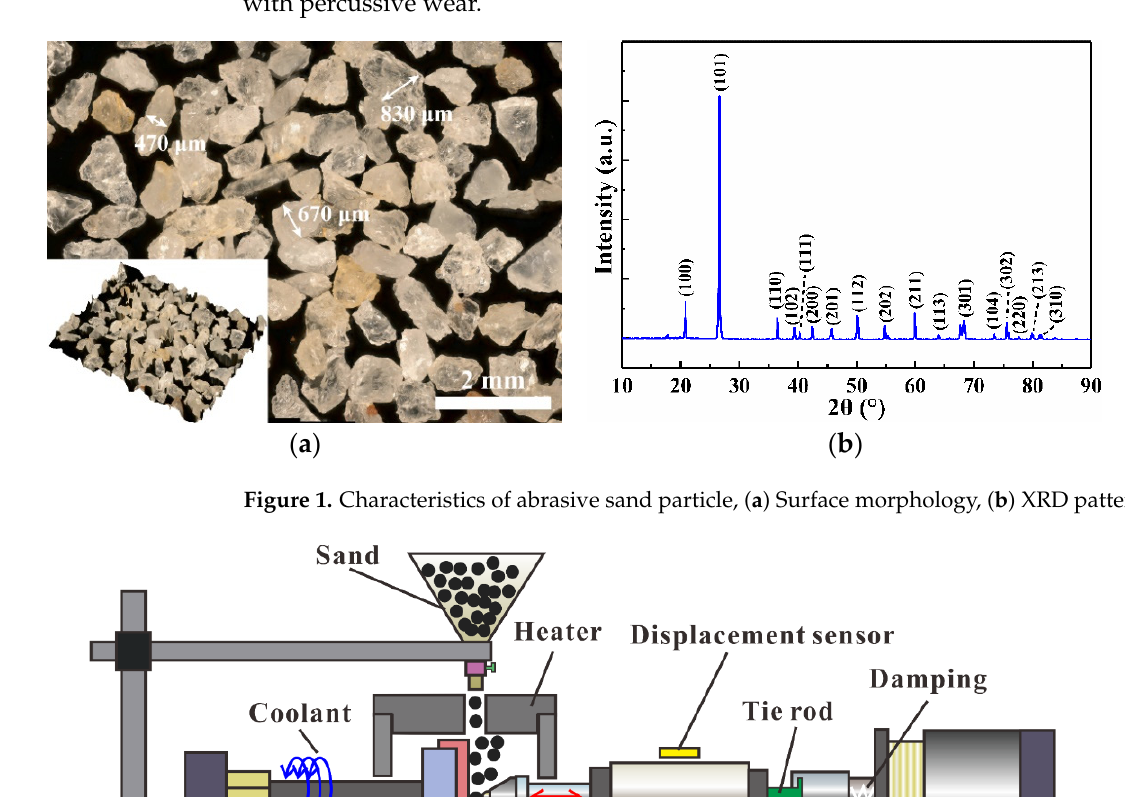
Figure 1. Characteristics of abrasive sand particle, ( a ) Surface morphology, ( b ) XRD pattern.